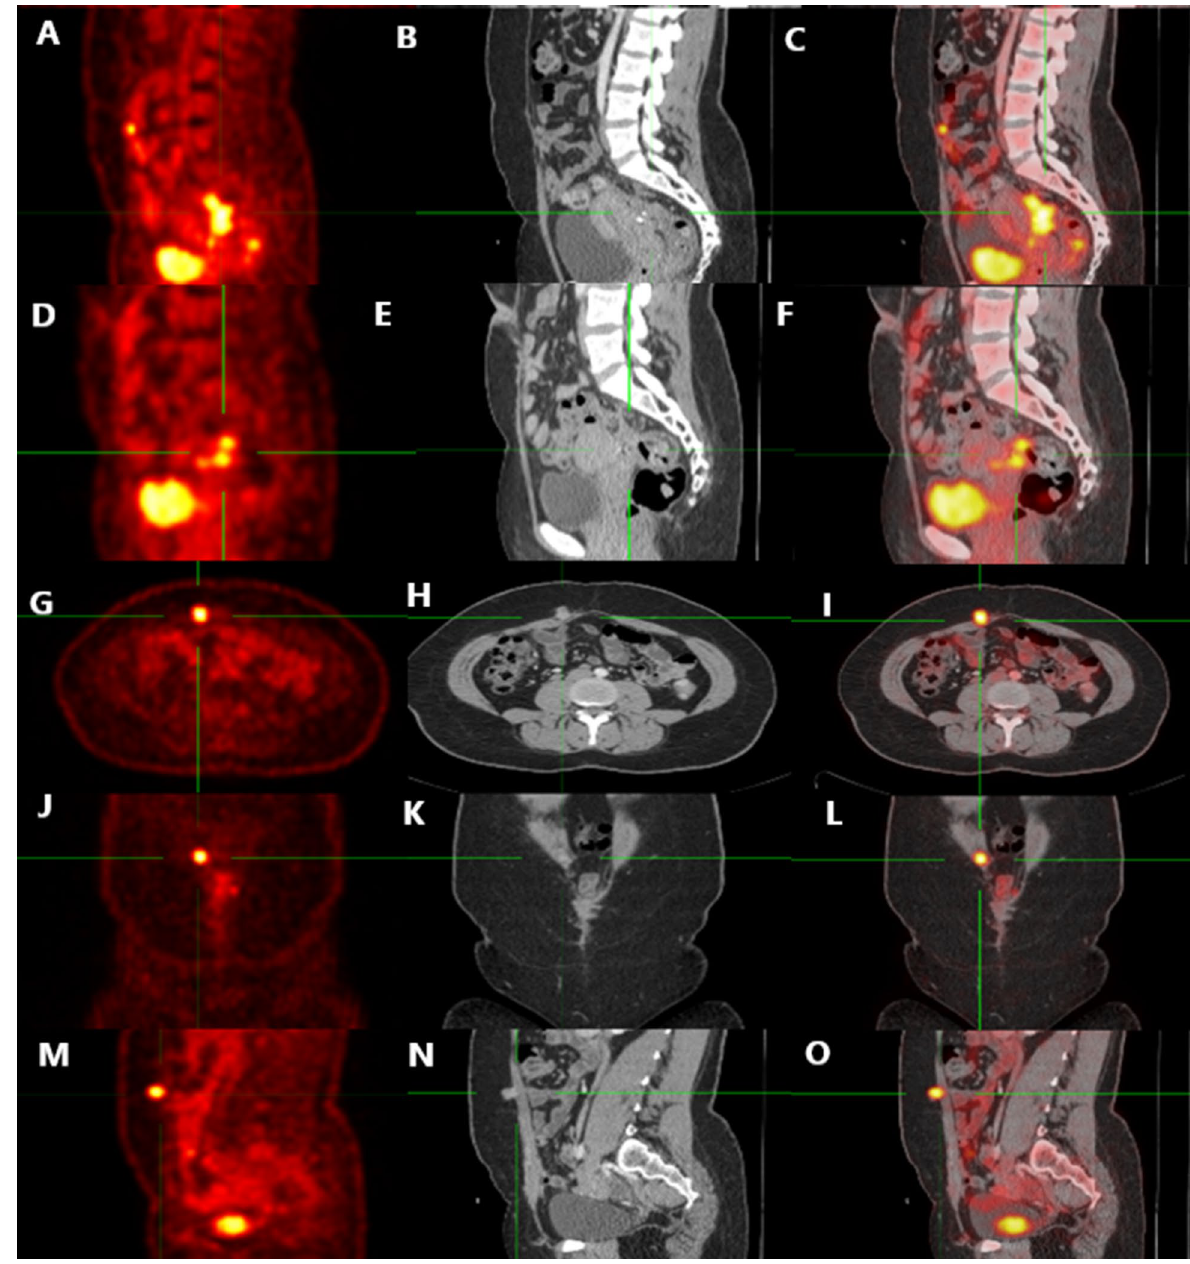
Fig. 1 48-year-old female patient with a history of surgically treated colon cancer. Follow-up 18F-FDG PET/CT scanning (images A – F ) revealed metabolic and morphologic regression of the previously noted nodular lesion in the recto-uterine pouch encroaching on the thickened rectal wall, with a SUVmax of 10.5 compared to 16.7. Other FDG-avid lesions (images G – O ) beneath and within the anterior abdominal wall (currently measuring about 1.0 cm vs. 1.7 cm, with aSUVmax of 2.8 vs.